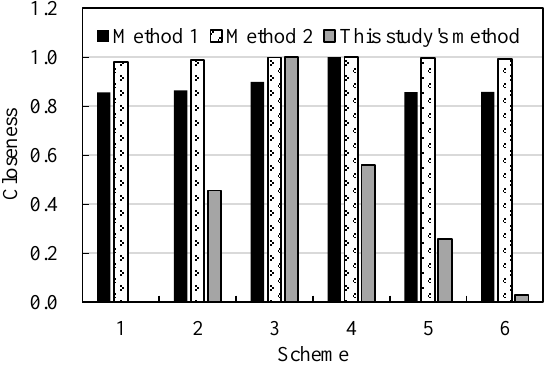
Figure 6. Comparison of closeness degree of each alternative scheme to the reference scheme.